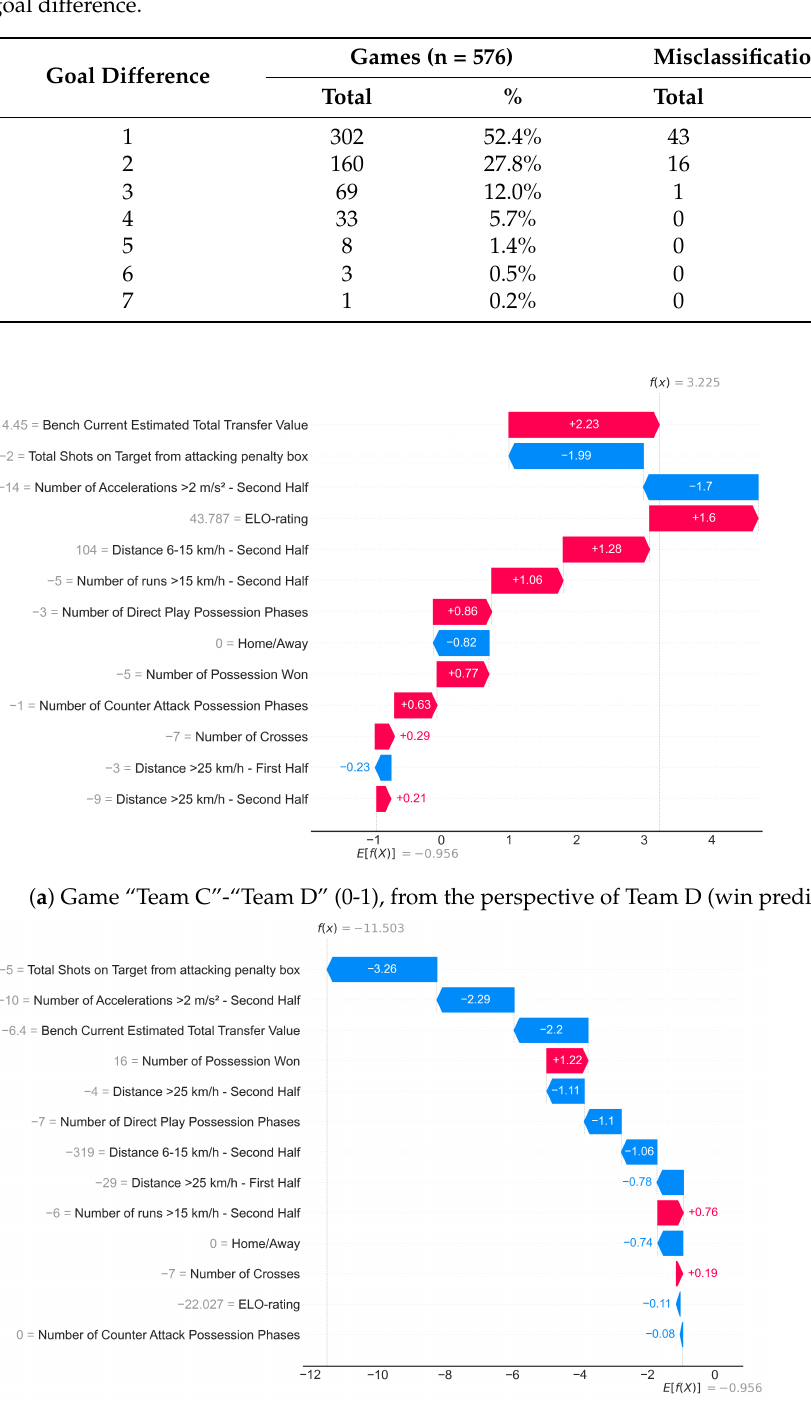
Figure 4. Two waterfall plots exampling local game predictions, showing the contribution of each variable to the prediction. The variable name is preceded by the value of the particular variable. Below the x-axis, the baseline value (E[f(X)]) is displayed, indicative of the expected value of the model evaluated on the background dataset. The SHAP-values of each variable are summed to match the model output with all variables included. Positive SHAP-values push the model to predict a win, while negative SHAP-values push the model to predict a